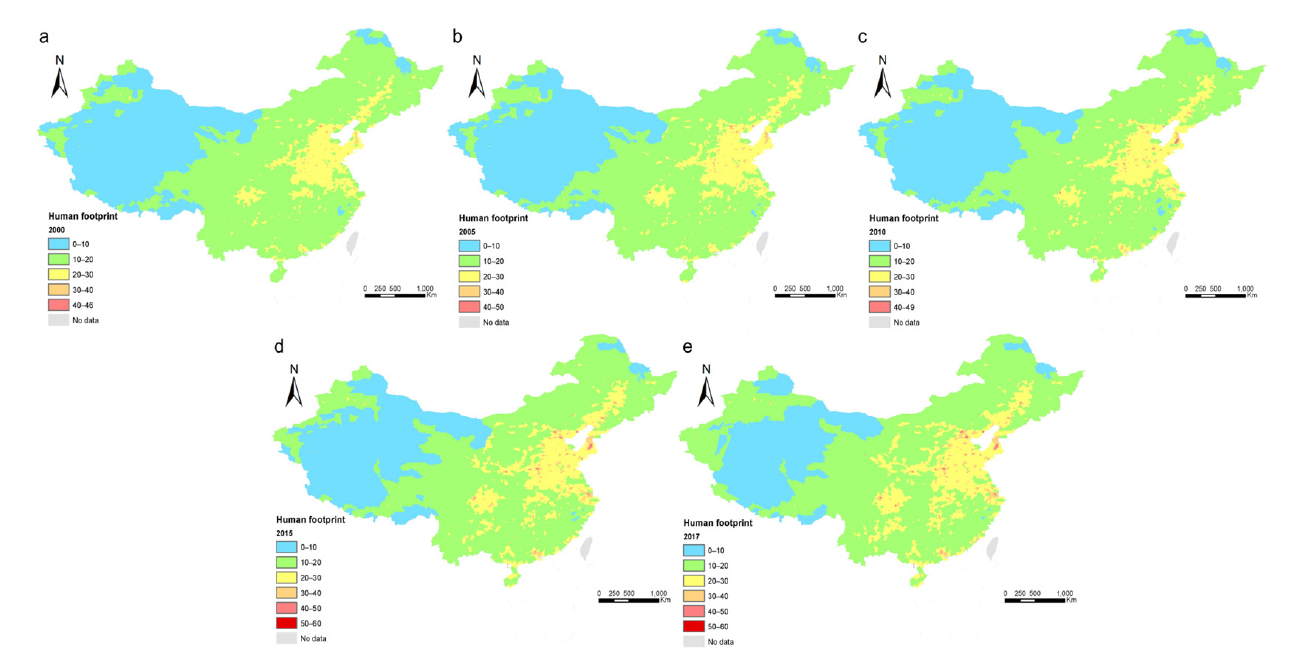
Figure 3. Spatio-temporal pattern of human footprint in China in ( a ) 2000, ( b ) 2005, ( c ) 2010, ( d ) 2015, and ( e ) 2017.